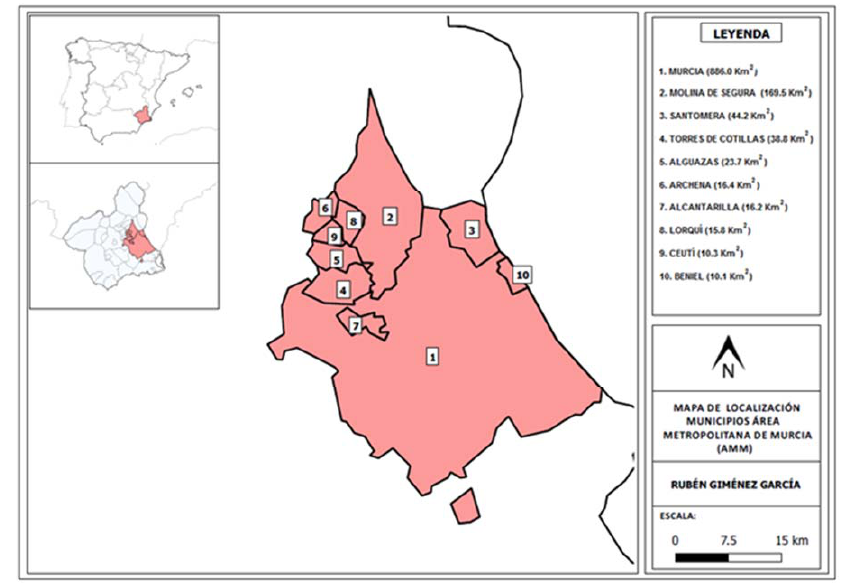
Figure 1. Location map of the Metropolitan Area of Murcia (MAM).